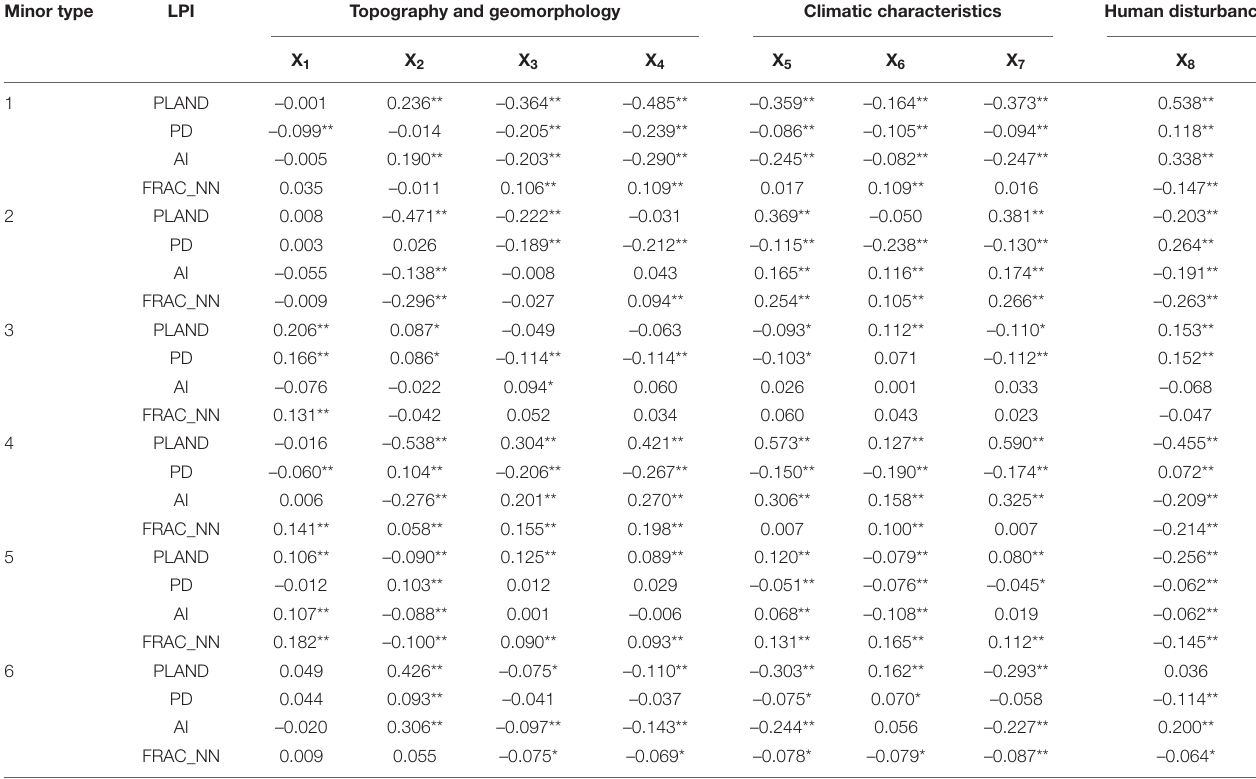
TABLE 5 | Bivariate correlations between landscape pattern indices (LPI) and driving factors at the class level. Minor type